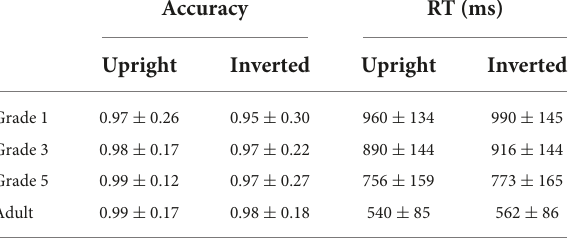
TABLE 1 The accuracy ( ± SD) and reaction time ( ± SD) in Experiment